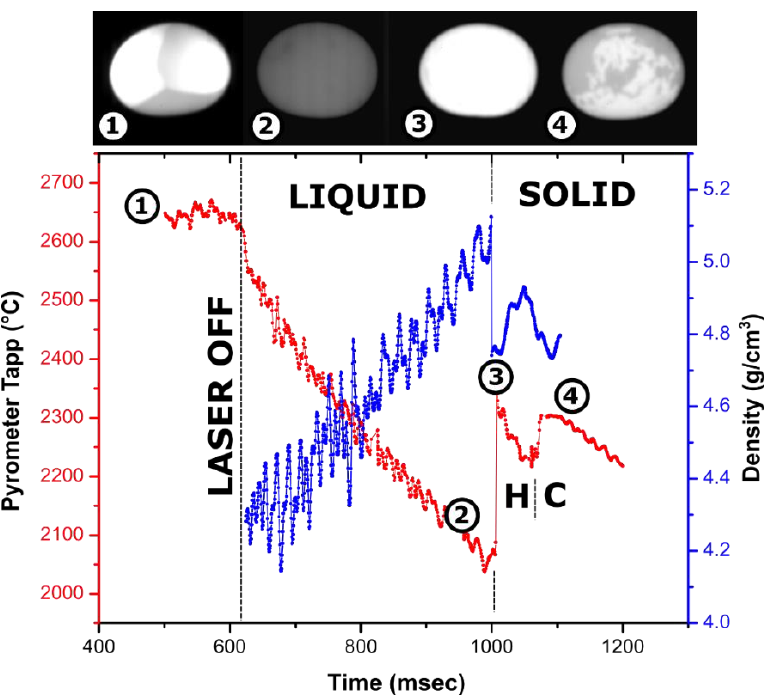
Figure 2. Cooling trace of a 59-mg Y 2 O 3 sample (~2.5 mm in diameter) melted in an Ar jet in an aero-acoustic levitator with overlayed density measurements and video frames (lateral view): (1)—molten droplet heated laterally with two laser beams which are visible as bright spots; (2)—undercooled liquid before crystallization; (3)—recalescence or “flash” on crystallization; (4)—phase transformation from high temperature hexagonal to cubic bixbyite phase. The brightness of images (2–4) was adjusted by the same degree for visibility. A video fragment is provided in Supplementary Materials (Video